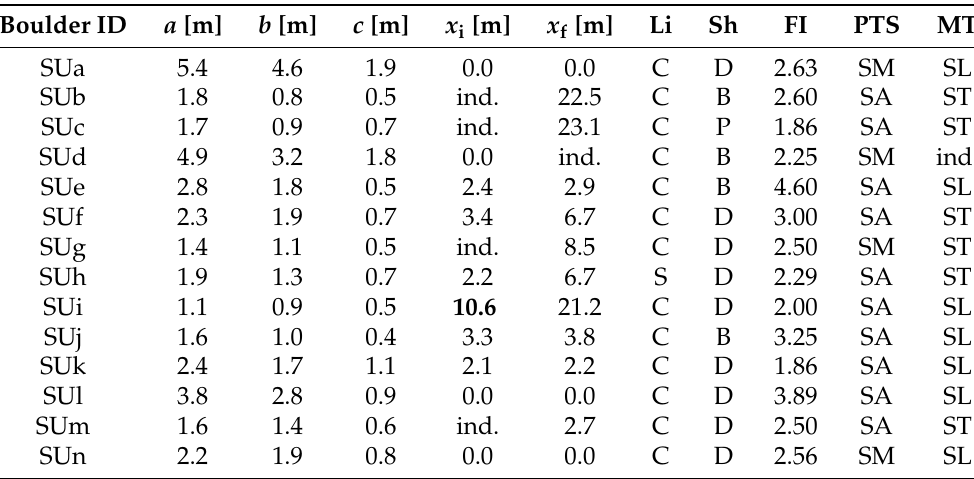
Table A10. Main features of the displaced boulders at the Torre Suda coast; see the caption of Table A2 for symbols.